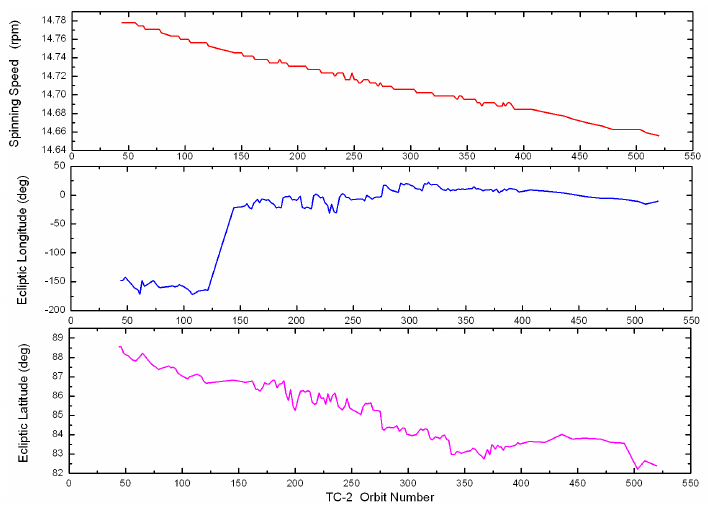
Fig. 4. Evolution of the TC-1 spinning speed (upper panel), the ecliptic latitude (mid panel) and ecliptic longitude (lower panel) of the spin axis of TC-2. Note that the Kepler period of TC-2 is about 11.5h.